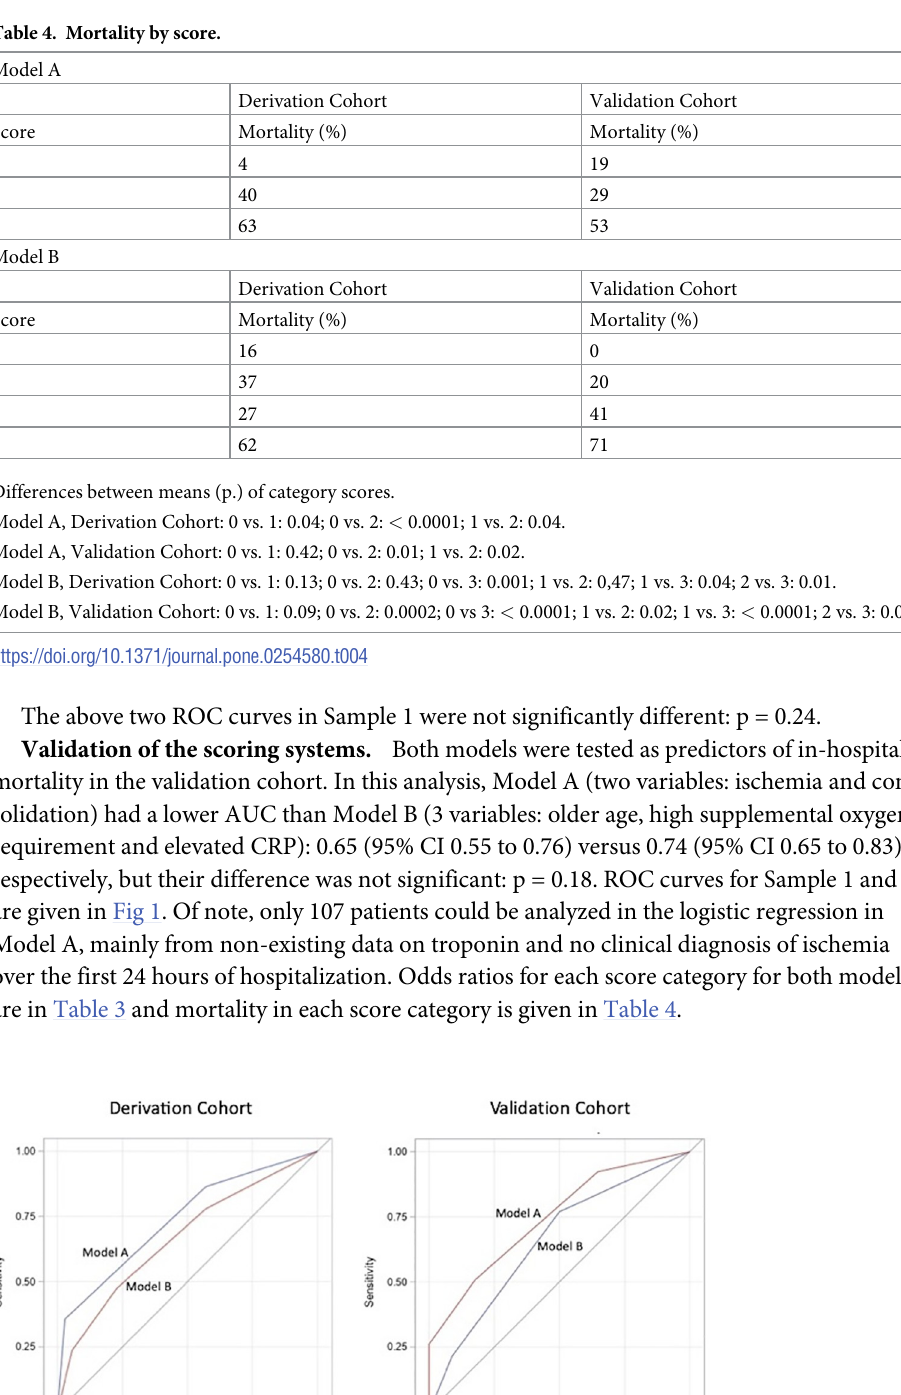
Table 4. Mortality by score.